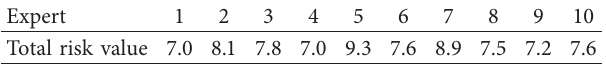
Table 10: The evaluation results of each expert.